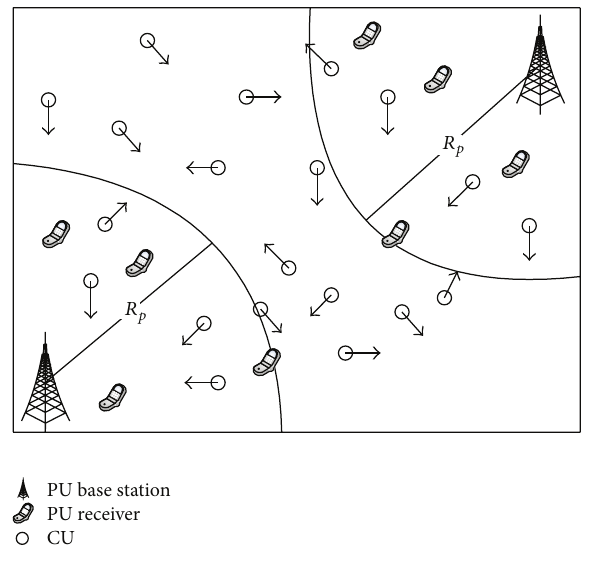
Figure 1: System model of a mobile CRN.